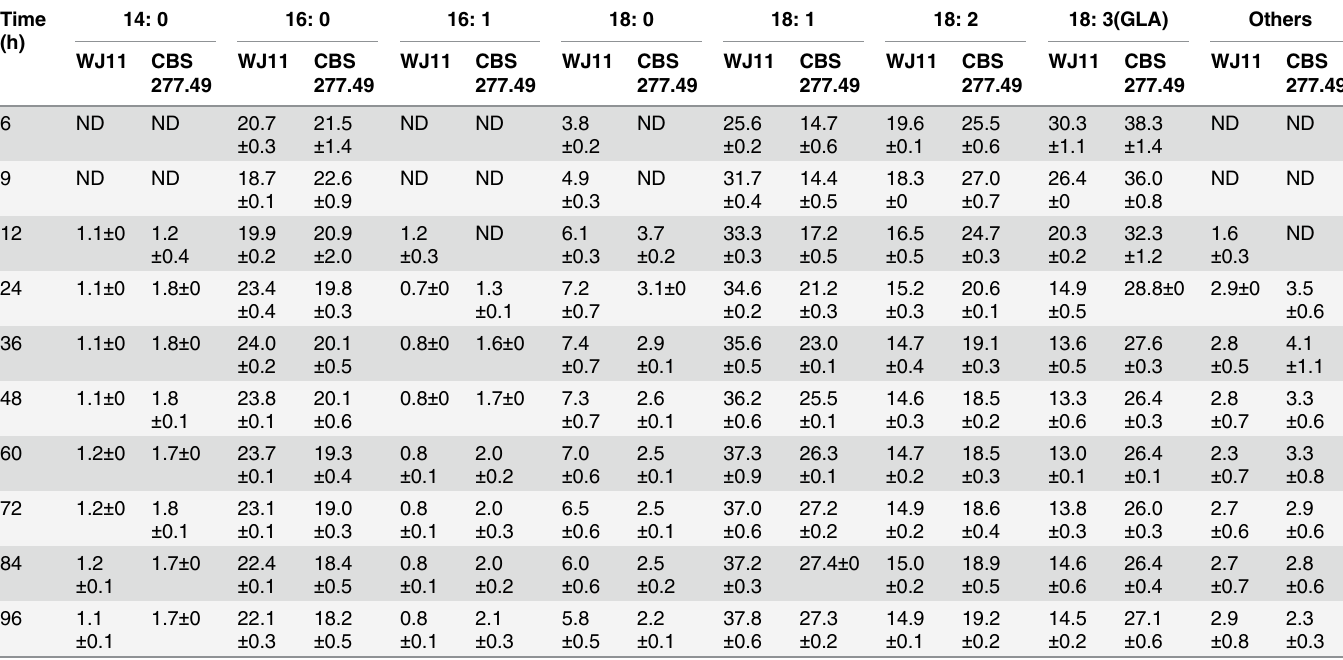
Table 1. Fatty acid composition (%, w/w of total fatty acids) of M . circinelloides WJ11 and CBS 277.49 during the fermentation.